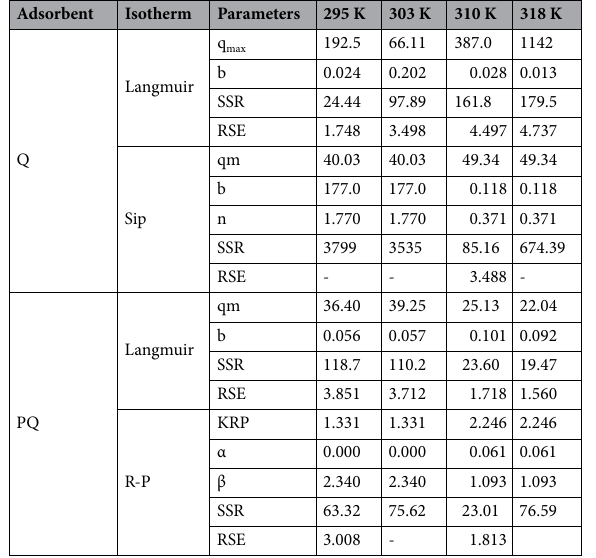
Table 3. Isotherm parameters for the adsorption of Cr(VI) onto PQ and Q. SSR sum of squared residuals, RSE the residual squared errors.